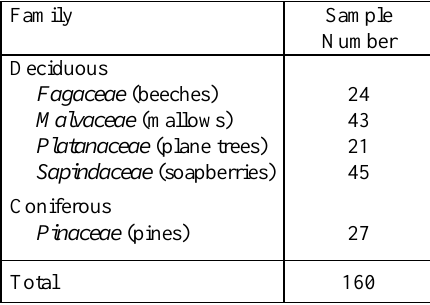
Table 1. Number of trees per family used for classification.